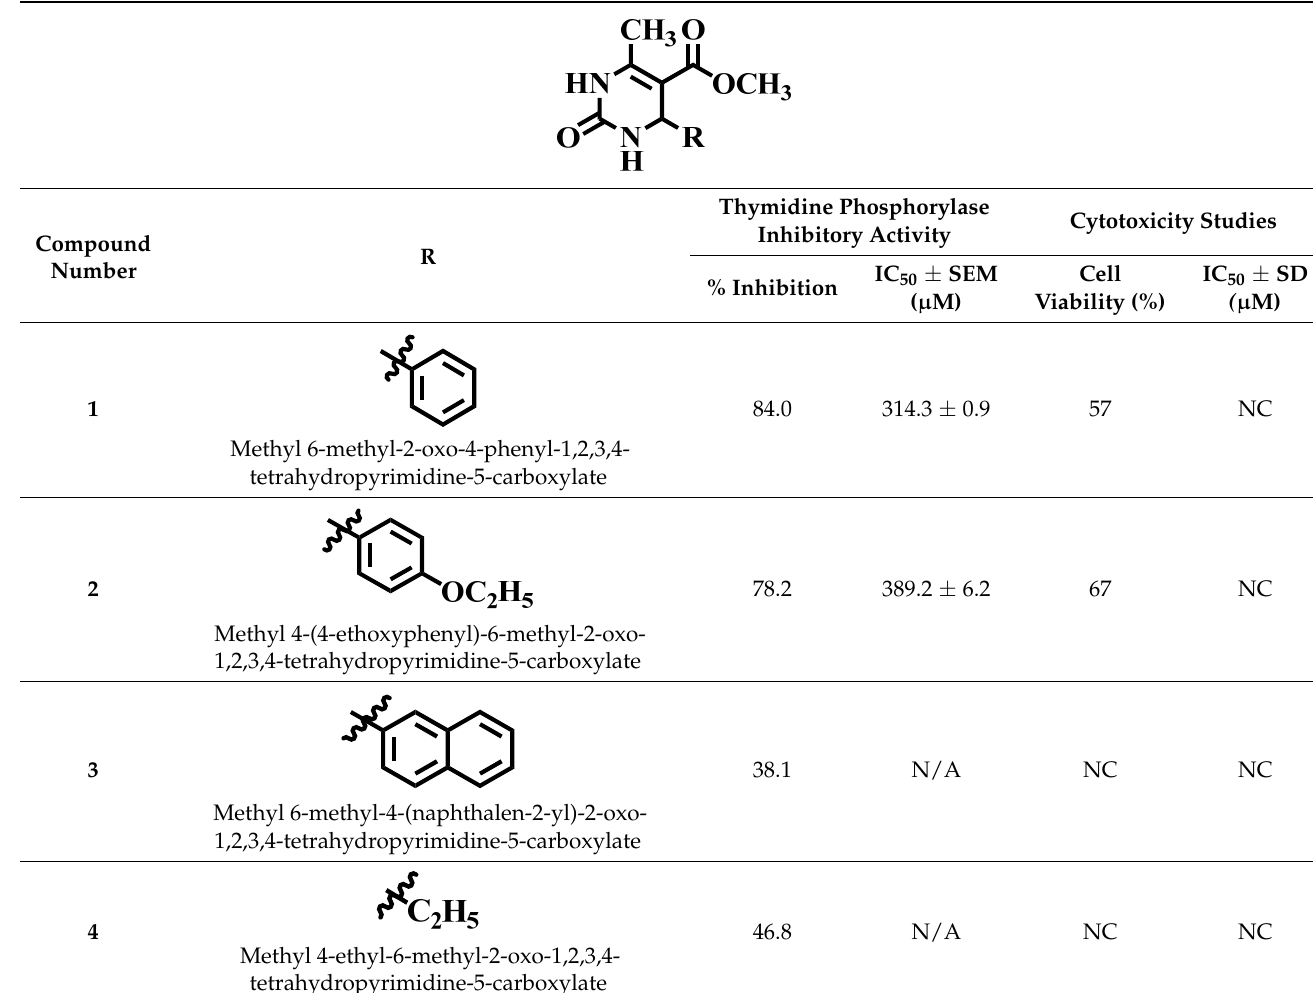
Table 1. Thymidine phosphorylase (TP) inhibitory activity of dihydropyrimidone ( 1 – 40 ).